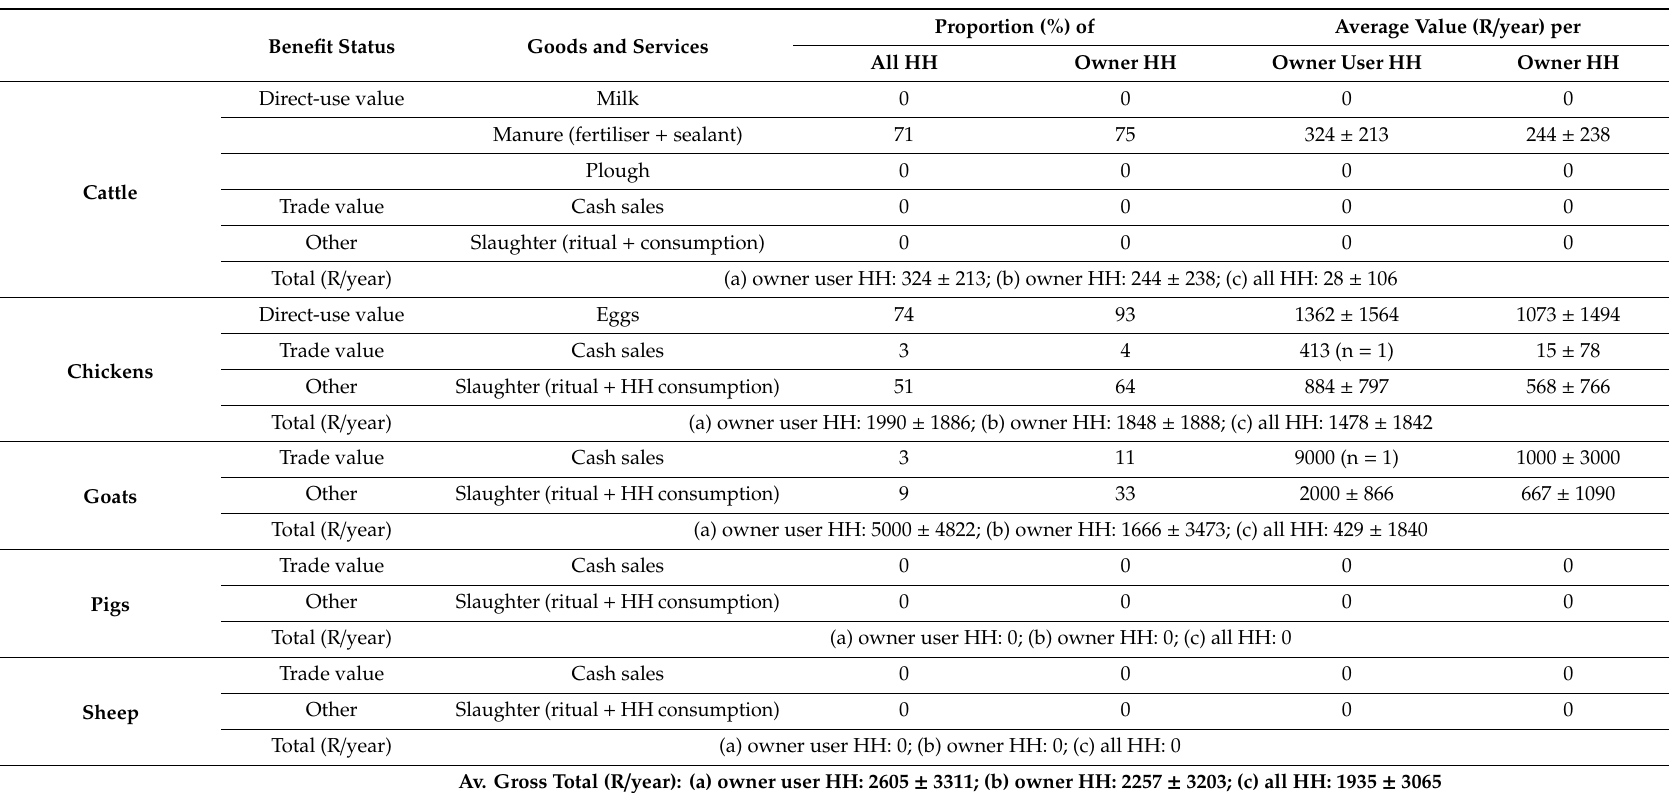
Table 3. Gross direct-use and traded values of livestock and poultry benefits to households in Njela 1,2